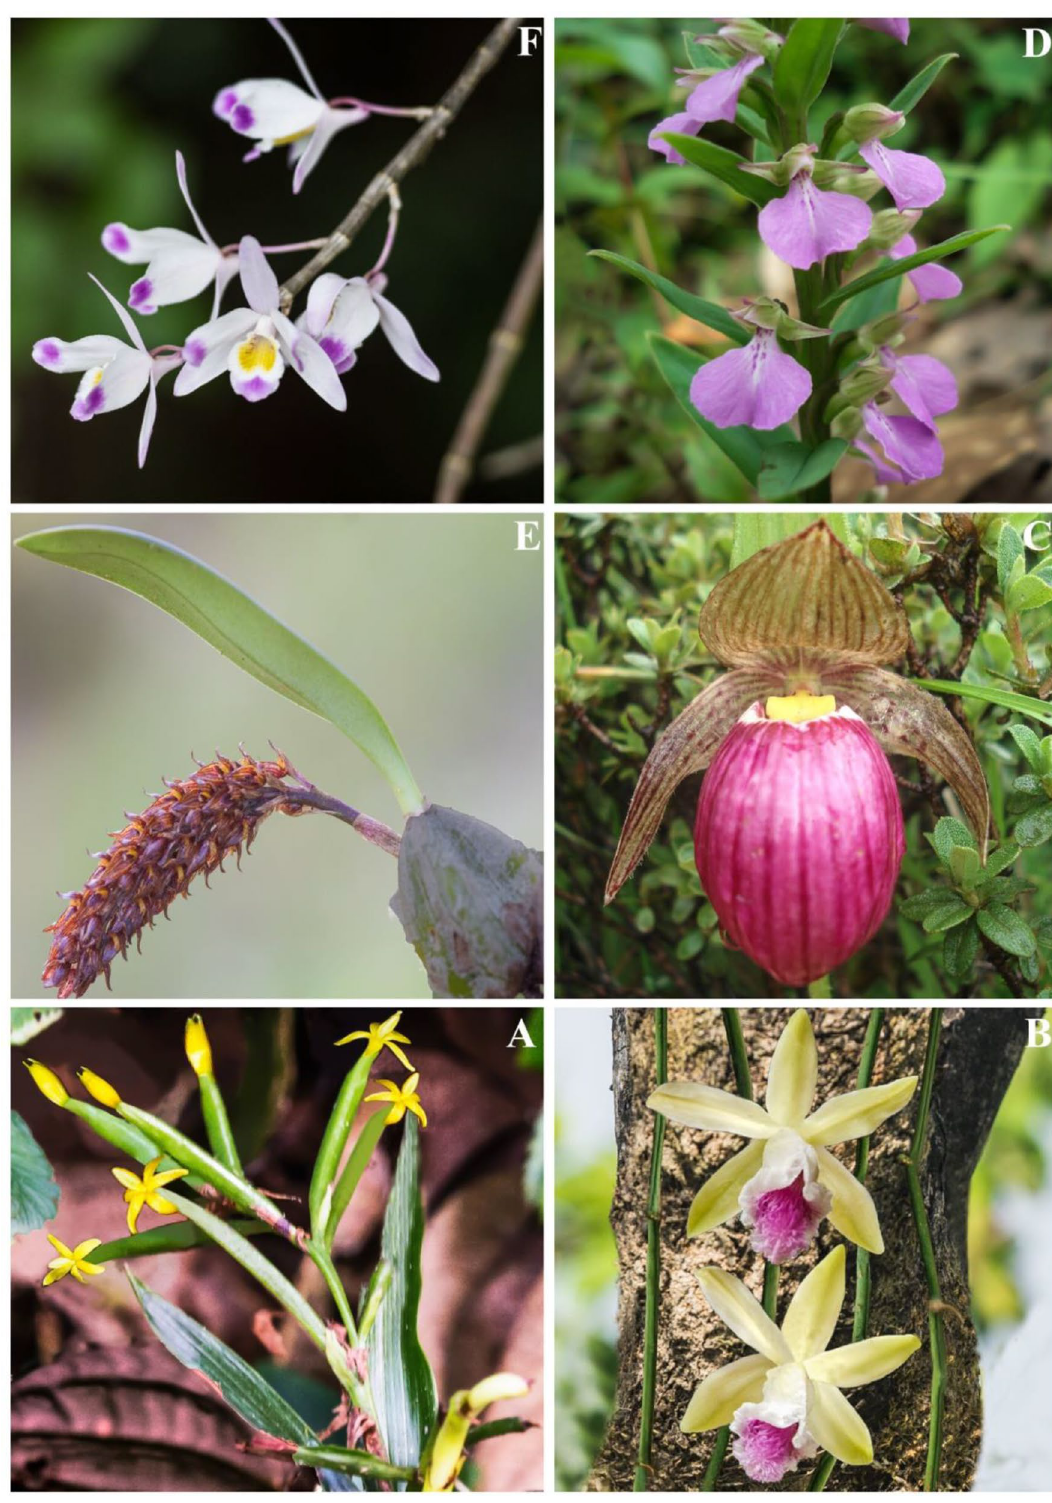
Figure 1. Representative species of medicinal orchids from five subfamilies. (A) Apostasia wallichii (Apostasioideae), (B) Vanilla aphylla (Vanilloideae), (C) Cypripedium himalaicum (Cypripedioideae), (D) Brachycorythis obcordata (Orchidoideae), (E) Bulbophyllum careyanum (Epidendroideae), (F) Dendrobium amoenum (Epidendroideae). Photographs by Bhakta B. Raskoti. Images merged in Adobe Illustrator CC v17.0. https:// www. adobe.